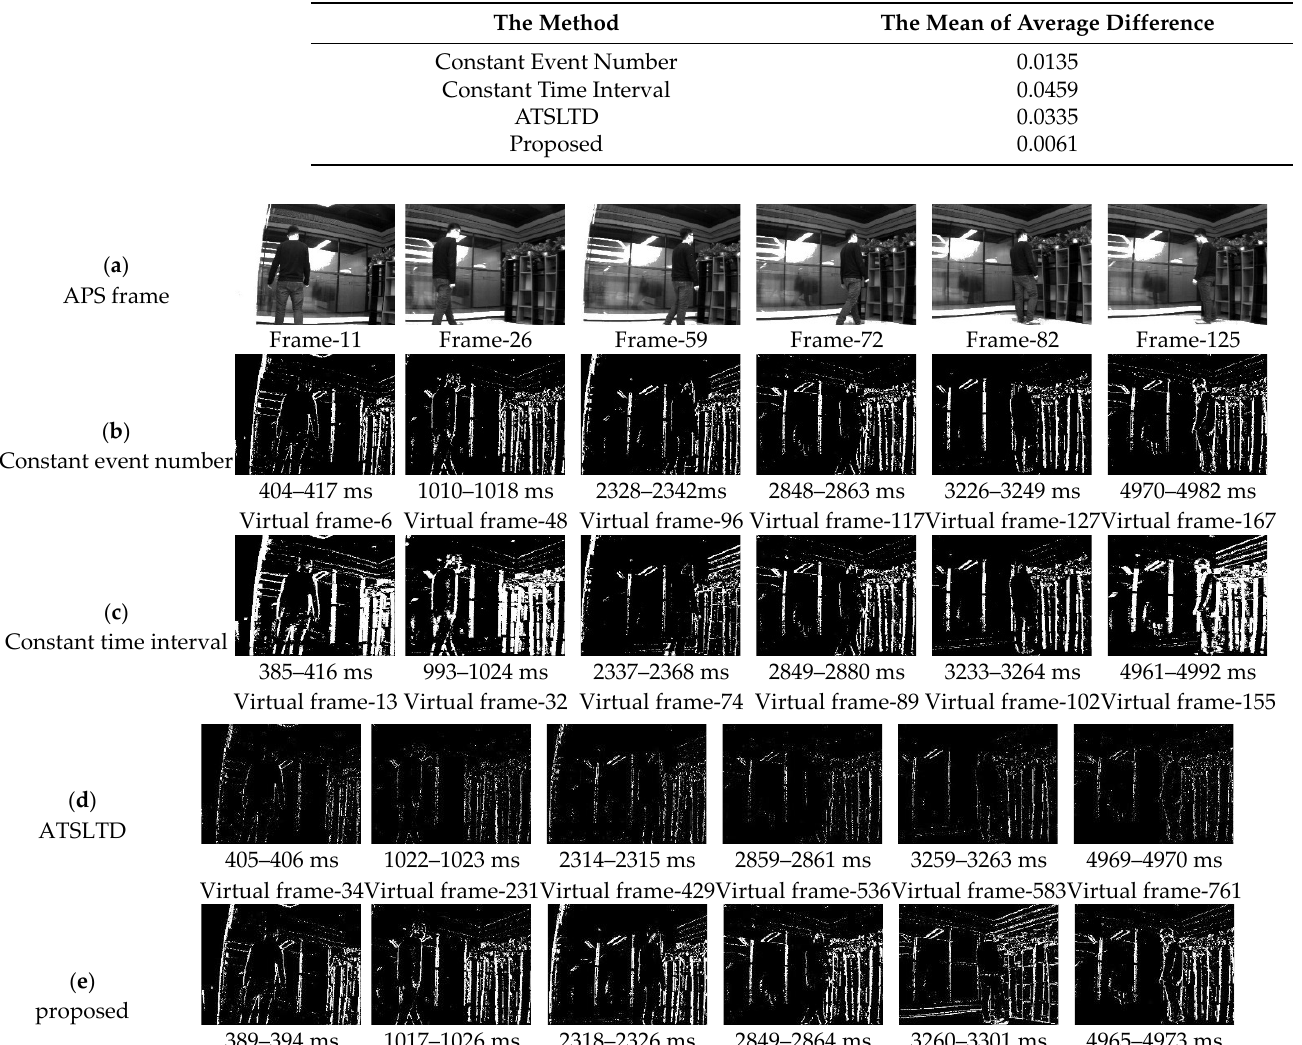
Figure 16. ( a ) APS frame; ( b ) virtual frame constructed with constant event number; ( c ) virtual frame constructed by constant time interval; ( d ) virtual frame constructed with ATSLTD; ( e ) virtual frame constructed with the proposed method.